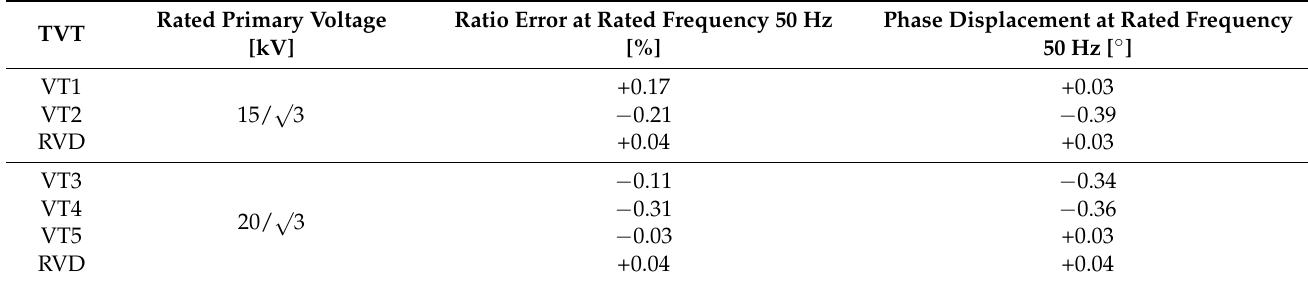
Table 4. Transformation accuracy of the sinusoidal primary voltage of frequency 50 Hz.